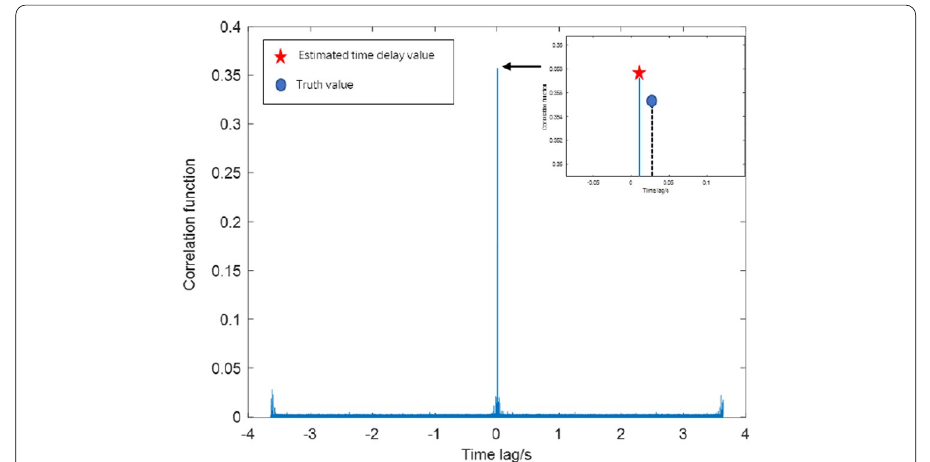
Fig. 16 EMD–ML pre-filter method (SNR